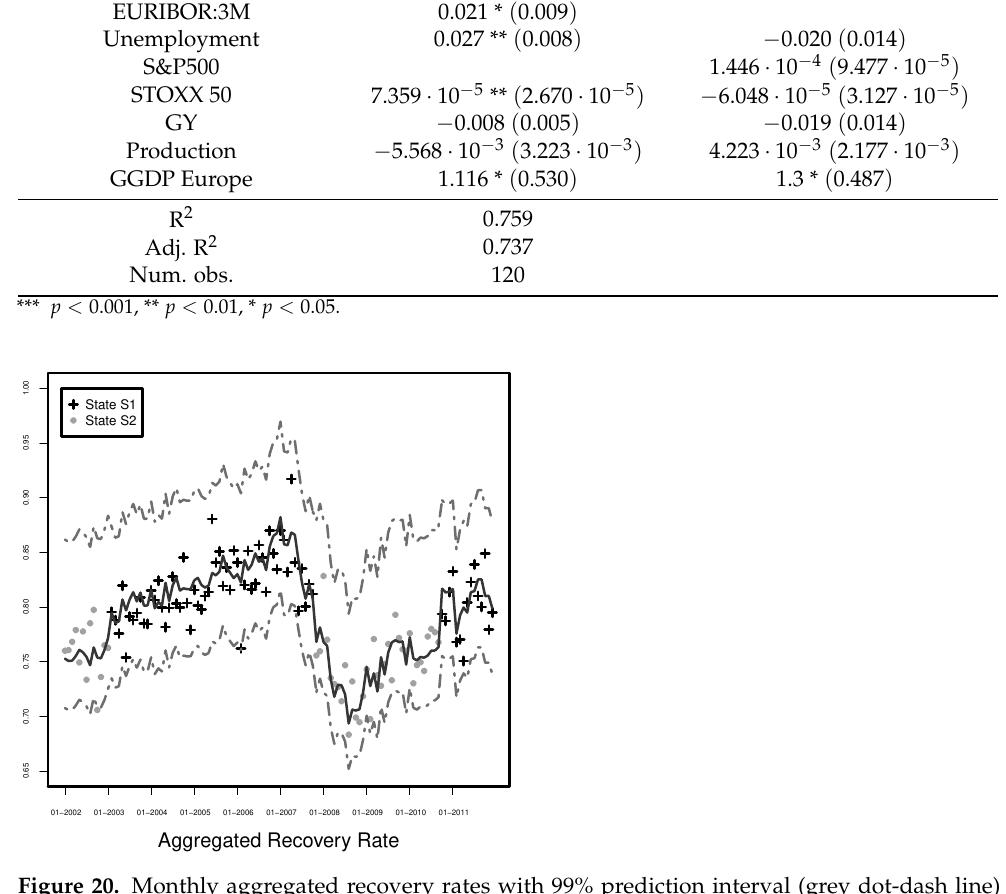
Figure 20. Monthly aggregated recovery rates with 99% prediction interval (grey dot-dash line) and the mean of the predictions (grey solid line) at the time of default for the reduced Markov switching